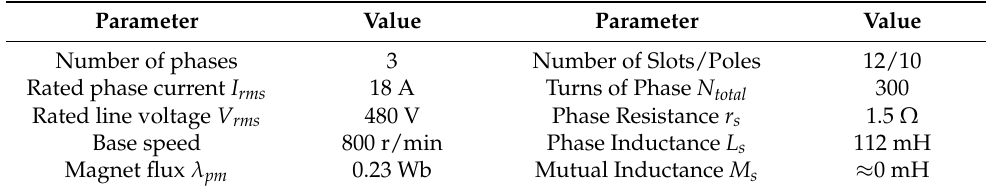
Table 1. Machine